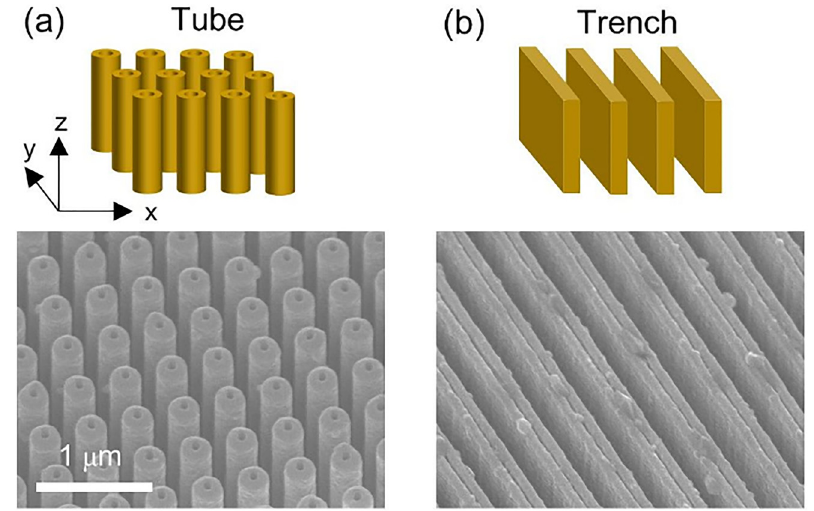
Figure 1: Schematics and SEM images of (a) TiNtubeand(b)TiNtrenchonSisubstrates. The SEM images were taken at 30 ° tilt.